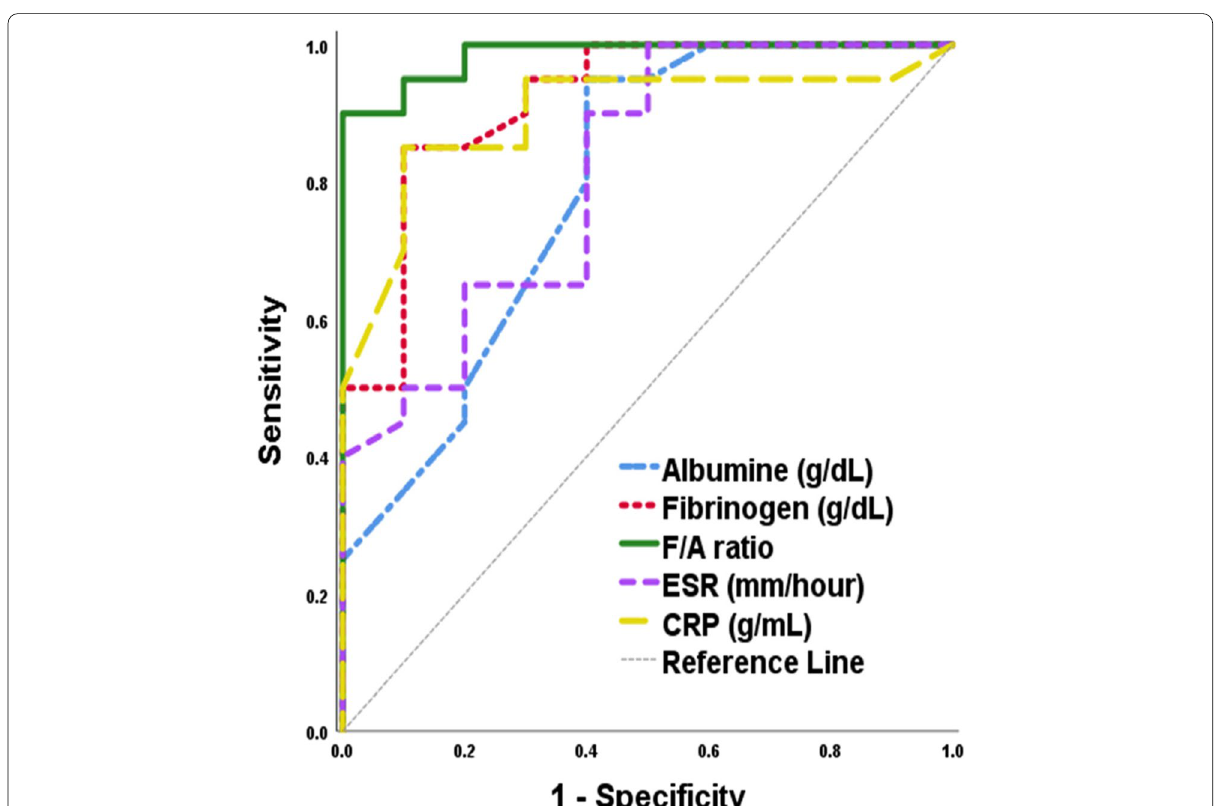
Fig. 2 ROC of albumin, fibrinogen, FAR, ESR, and CRP for the prediction of